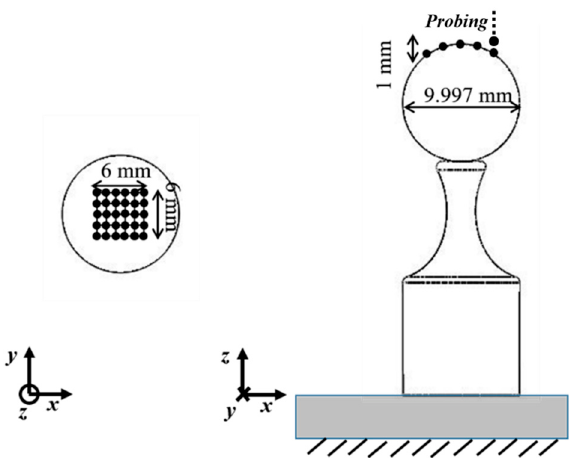
Figure 3. Probing points on the standard sphere (left: 𝑧 view; Right: 𝑦